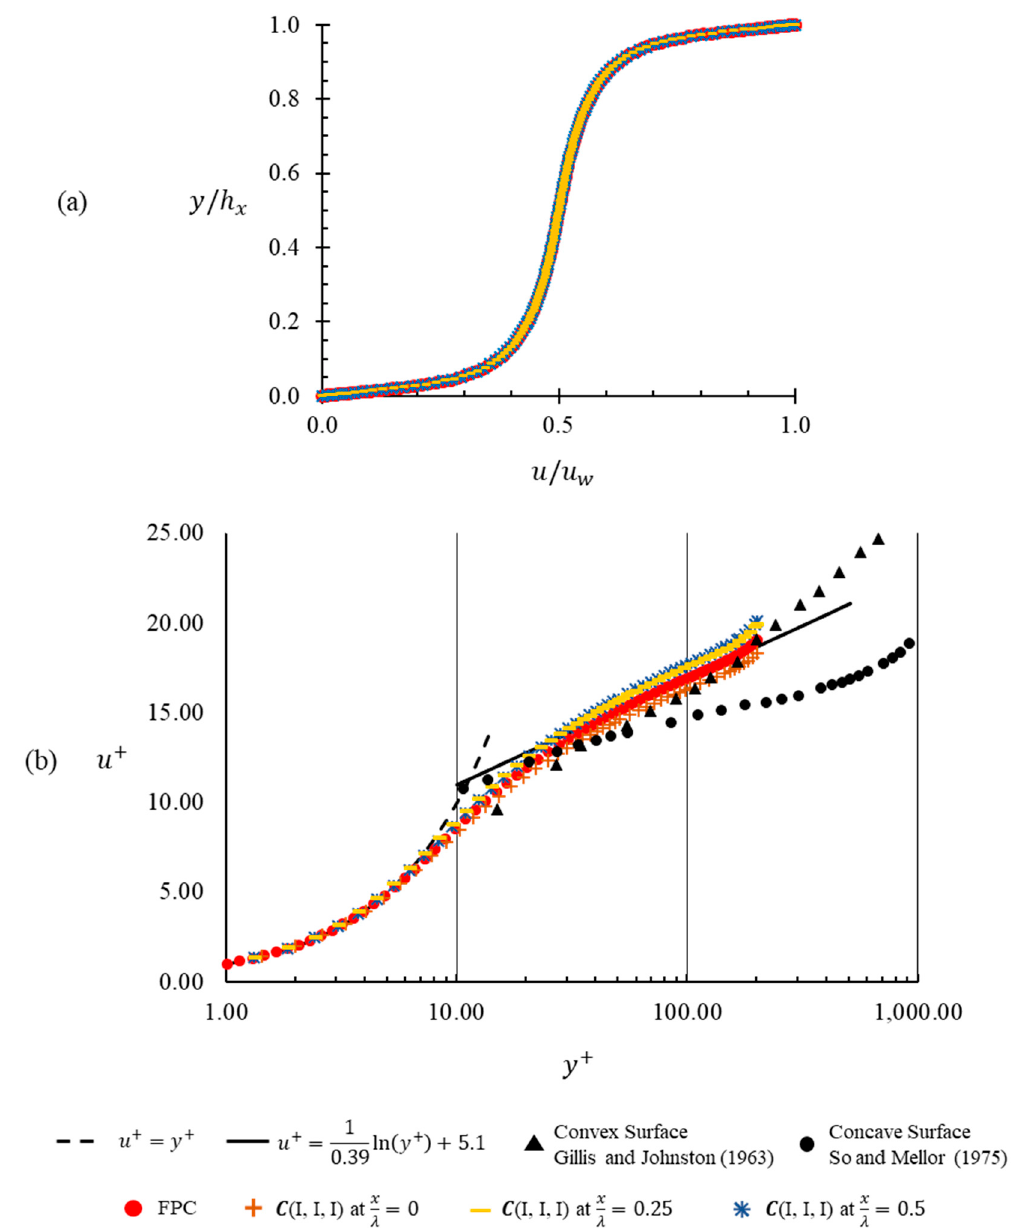
Figure 6. Comparison of 𝑪 (I, I, I) and FPC: ( a ) Mean velocity profiles. ( b ) Law of the wall fit on wavy plate. Experimental data of Gillis and Johnston, and So and Mellor respectively reproduced from Bandyopadhyay [29].